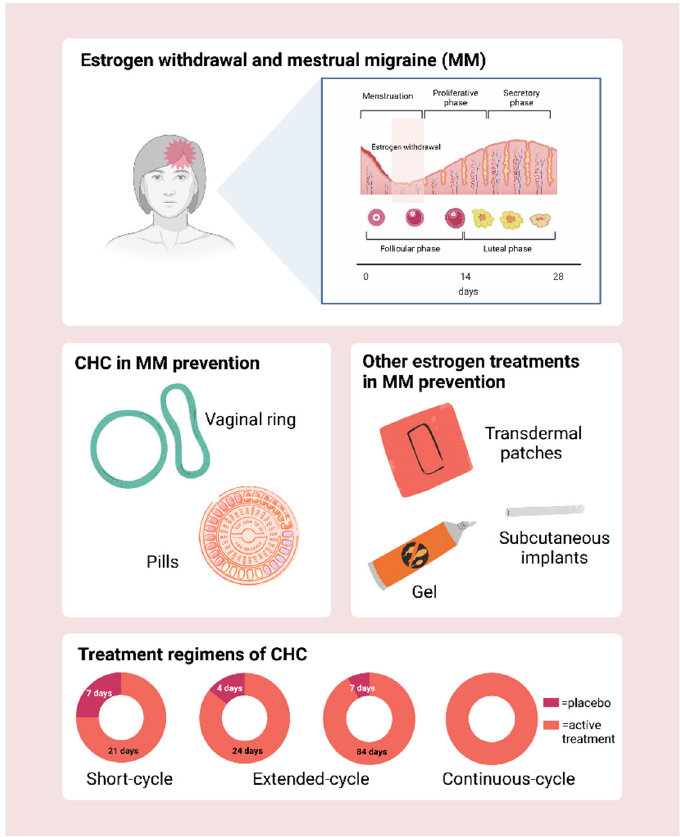
Figure 1. Schematic phases of the menstrual cycle (top panel); types of combined hormonal contraception (CHC) and other estrogen treatments evaluated in menstrual migraine (MM) prevention (middle panel); main treatment regimens of CHC (bottom panel). Created with BioRender.com. (2022).